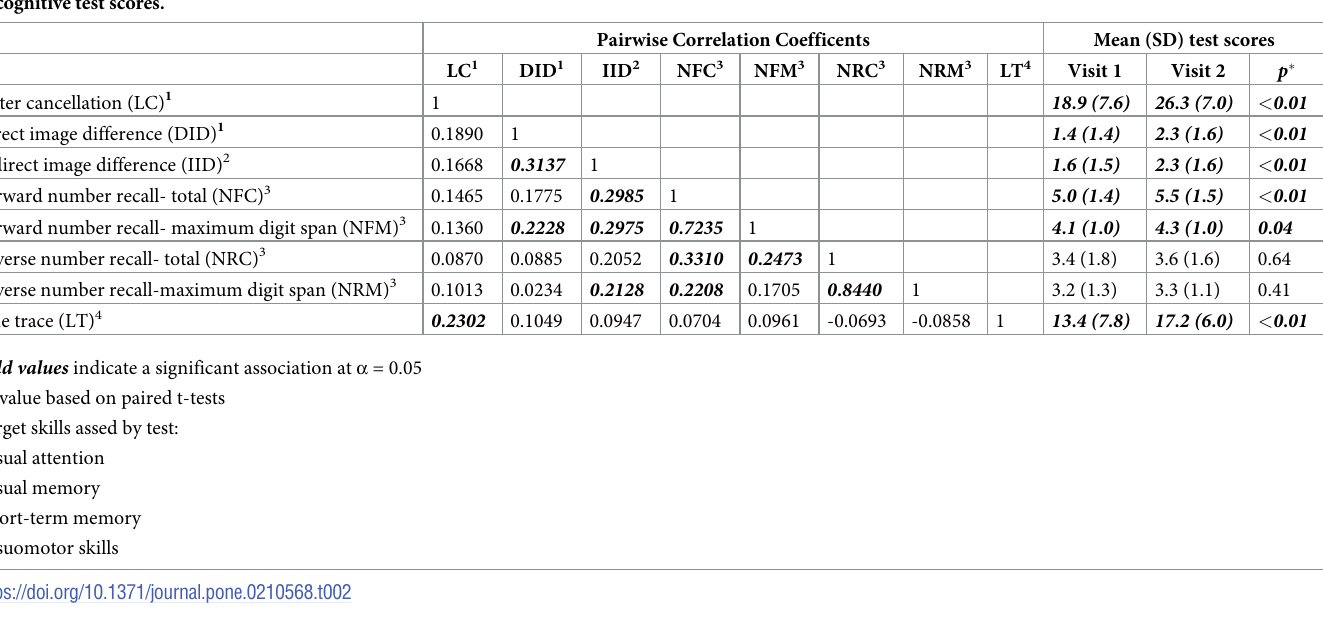
classified as dehydrated in the afternoon under the water condition compared to the control condition. However, mean afternoon U compared to the water condition (Table 1). U